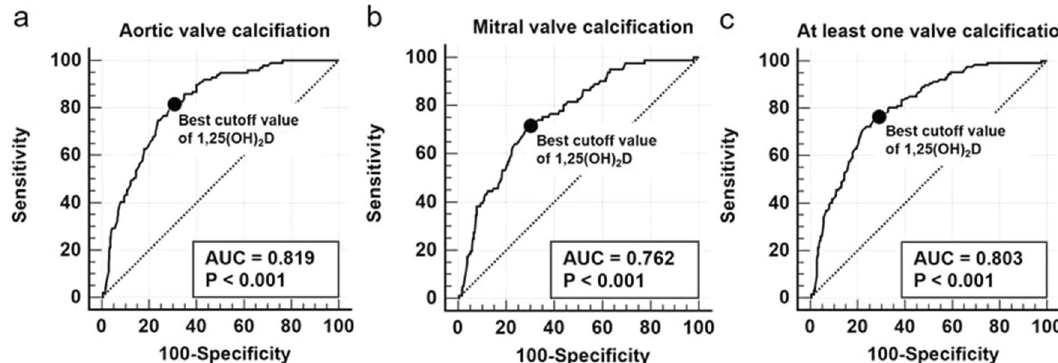
Figure 1. Receiver-operating characteristic curves of serum 1,25(OH) 2 D levels for predicting the presence of AVC ( a ), MVC ( b ) or at least one valve calcification ( c ) in patients with pre-dialysis CKD (n = 513). The areas under the curve for serum 1,25(OH) 2 D levels were 0.819 [95% confidence interval (CI): 0.783–0.852, P < 0.001] for AVC, 0.762 (95% CI 0.722–0.798, P < 0.001) for MVC, and 0.803 (95% CI 0.766–0.837, P < 0.001) for at least one valve calcification. The best cutoff value of serum 1,25(OH) 2 D level for predicting the presence of AVC was ≤ 12.5 pg/dl with an associated sensitivity of 80.8% and specificity of 70.0%. The best cutoff of serum 1,25(OH) 2 D level for predicting the presence of MVC was ≤ 11.9 pg/dl with an associated sensitivity of 71.6% and specificity of 70.8%. Finally, the best cutoff value of serum 1,25(OH) 2 D level for predicting the presence of at least one valve calcification was ≤ 12.5 pg/dl with an associated sensitivity of 76.4% and specificity of 72.3%. AUC, area under the curve; AVC, aortic valve calcification; CI, confidence interval; CKD, chronic kidney disease; MVC, mitral valve calcification; 1,25(OH) 2 D, 1,25-dihydroxyvitamin